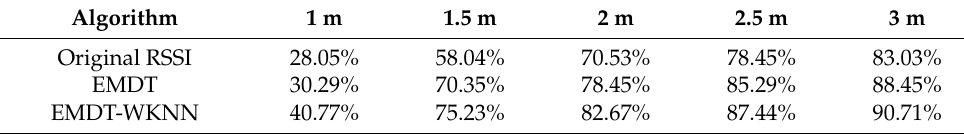
Figure 16. CDF of positioning error. Table 3. Cumulative error probability of different algorithms under fixed accuracy limit.